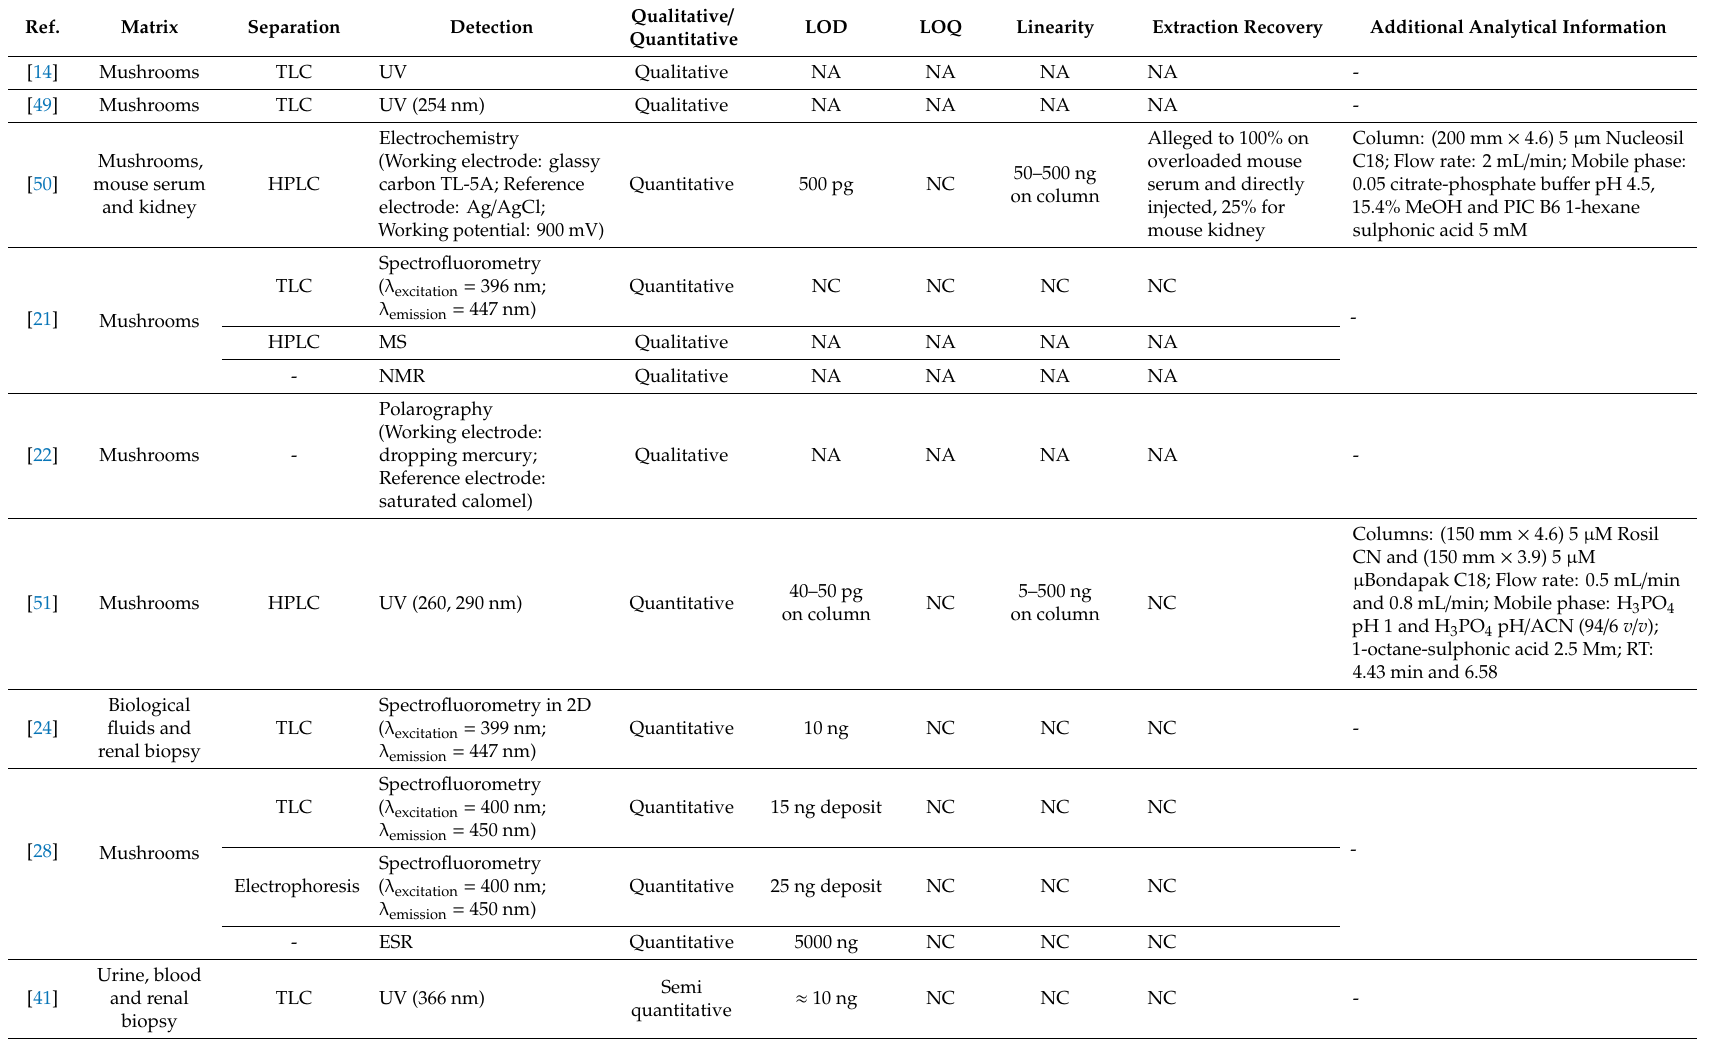
Table 2. Analytical methods for orellanine